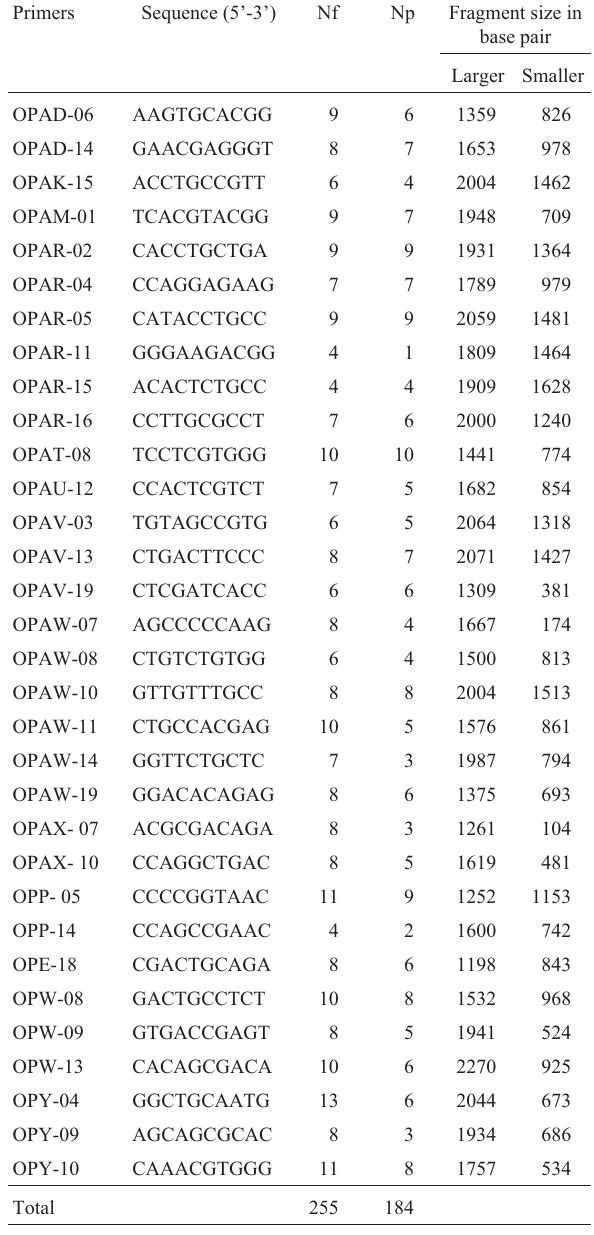
Table 2 - Decamer oligonucleotide primers (Operon Technologies Inc.) selectedforRAPDanalysisof81accessionsofmaizeincludingnumberof fragments for each primer and number and size of polymorphic fragment produced.